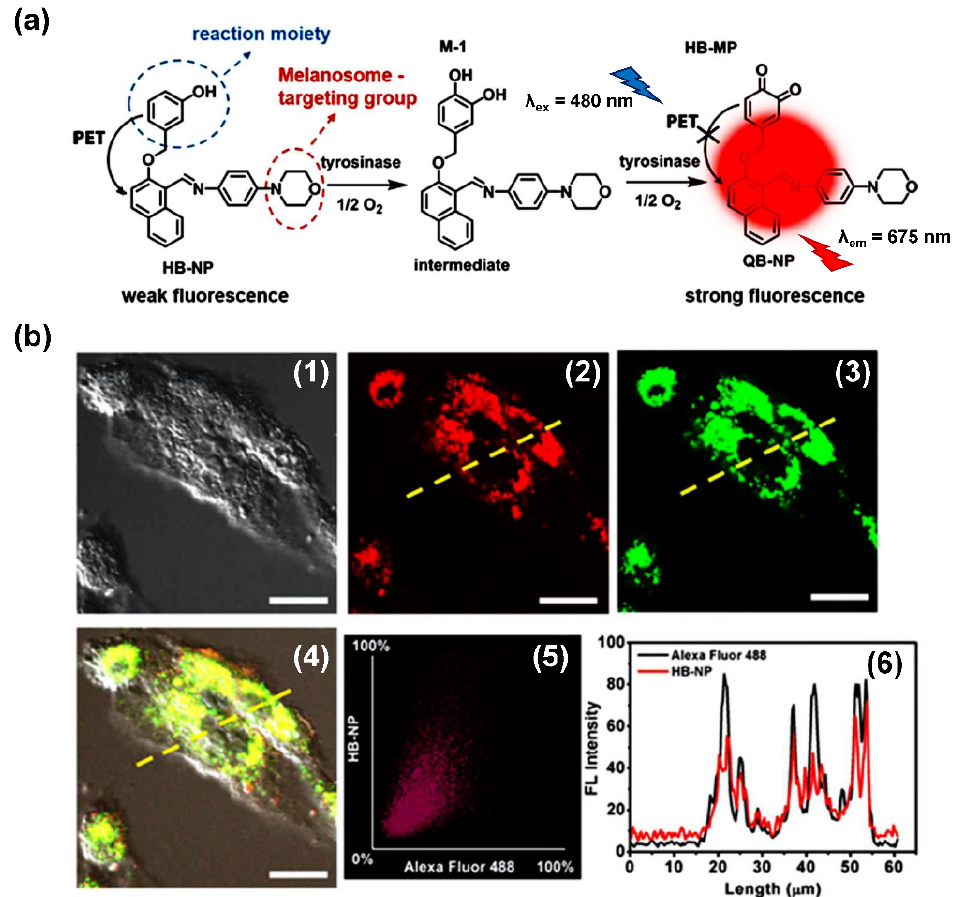
Figure 10. ( a ) The mechanism of TYR activity detected by HB-NP. ( b ) Colocalization of HB-NP and Alexa Fluor 488 (a commercial dye) in B16 cells [80]. (1) Bright-field image of the B16 cells; (2) fluorescence image of the red channel for HB-NP; (3) fluorescence image of the green channel for Alexa Fluor 488 ( λ ex = 488 nm, λ em = 500–555 nm); (4) the merged image of (1)–(3). (4) Intensity correlation plot of HB-NP and Alexa Fluor 488. (6) Intensity profile of the linear ROI across the cell (yellow line in images (2)–(4)). Copyright permission is granted by American Chemical Society.